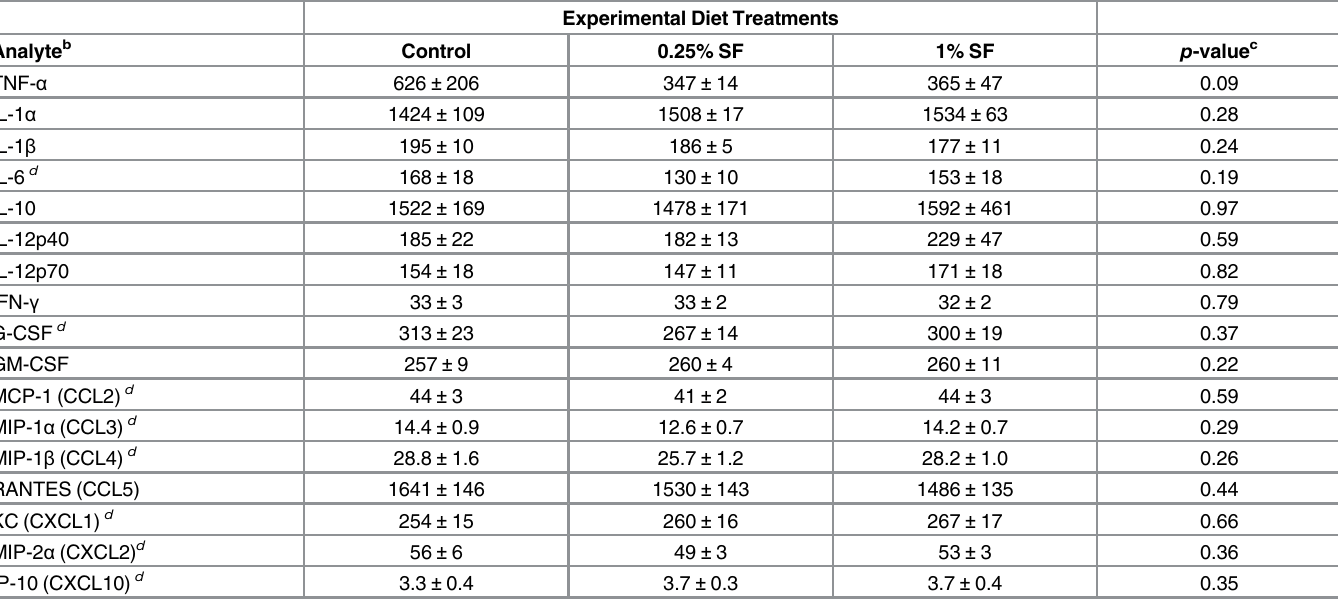
Table 3. S . frutescens Consumption Failed to Impact Circulating Cytokines and Chemokines in C57Bl/6 Mice 2 hr Following an Injection with Lipo- polysaccharide from E . coli . a